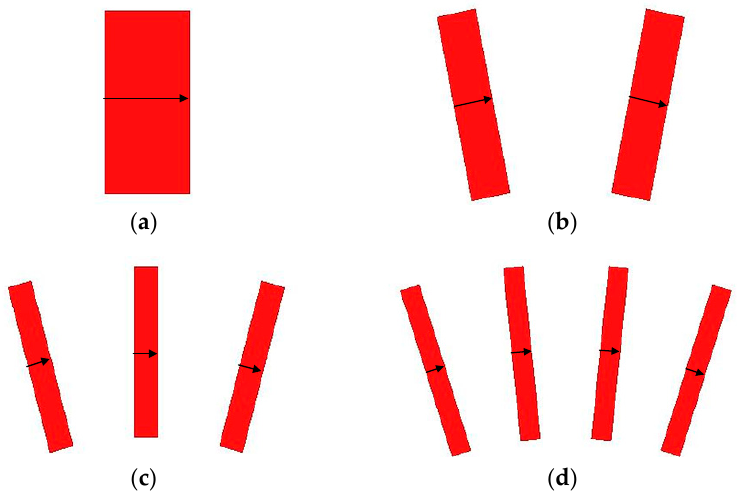
Figure 6. Four inner rotor spoke-type structures: ( a ) one segment; ( b ) two segments; ( c ) three segments; and ( d ) four segments.